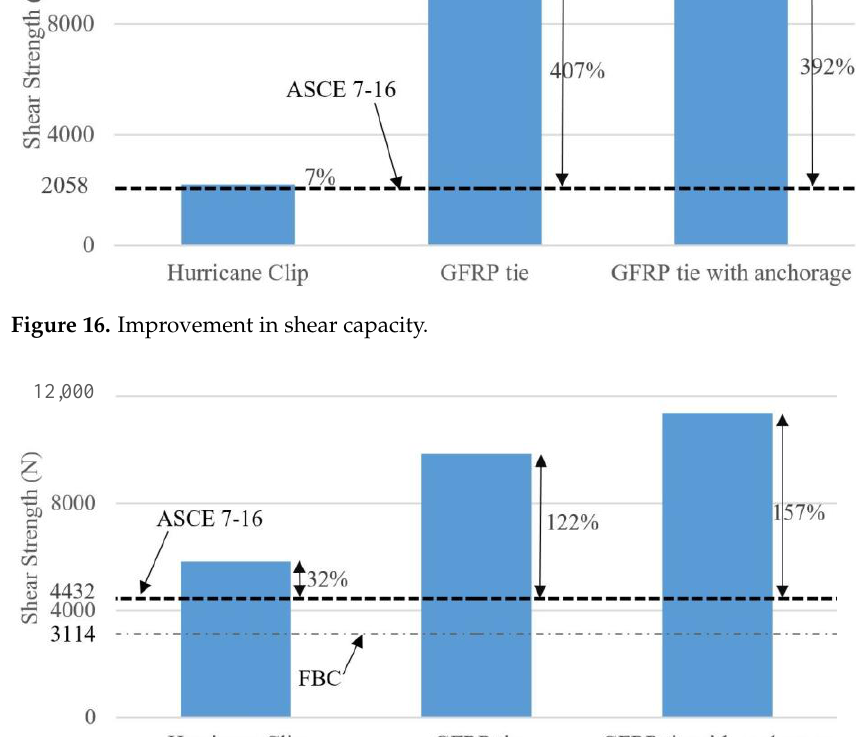
Table 7. Shear strength various GFRP bonded areas.